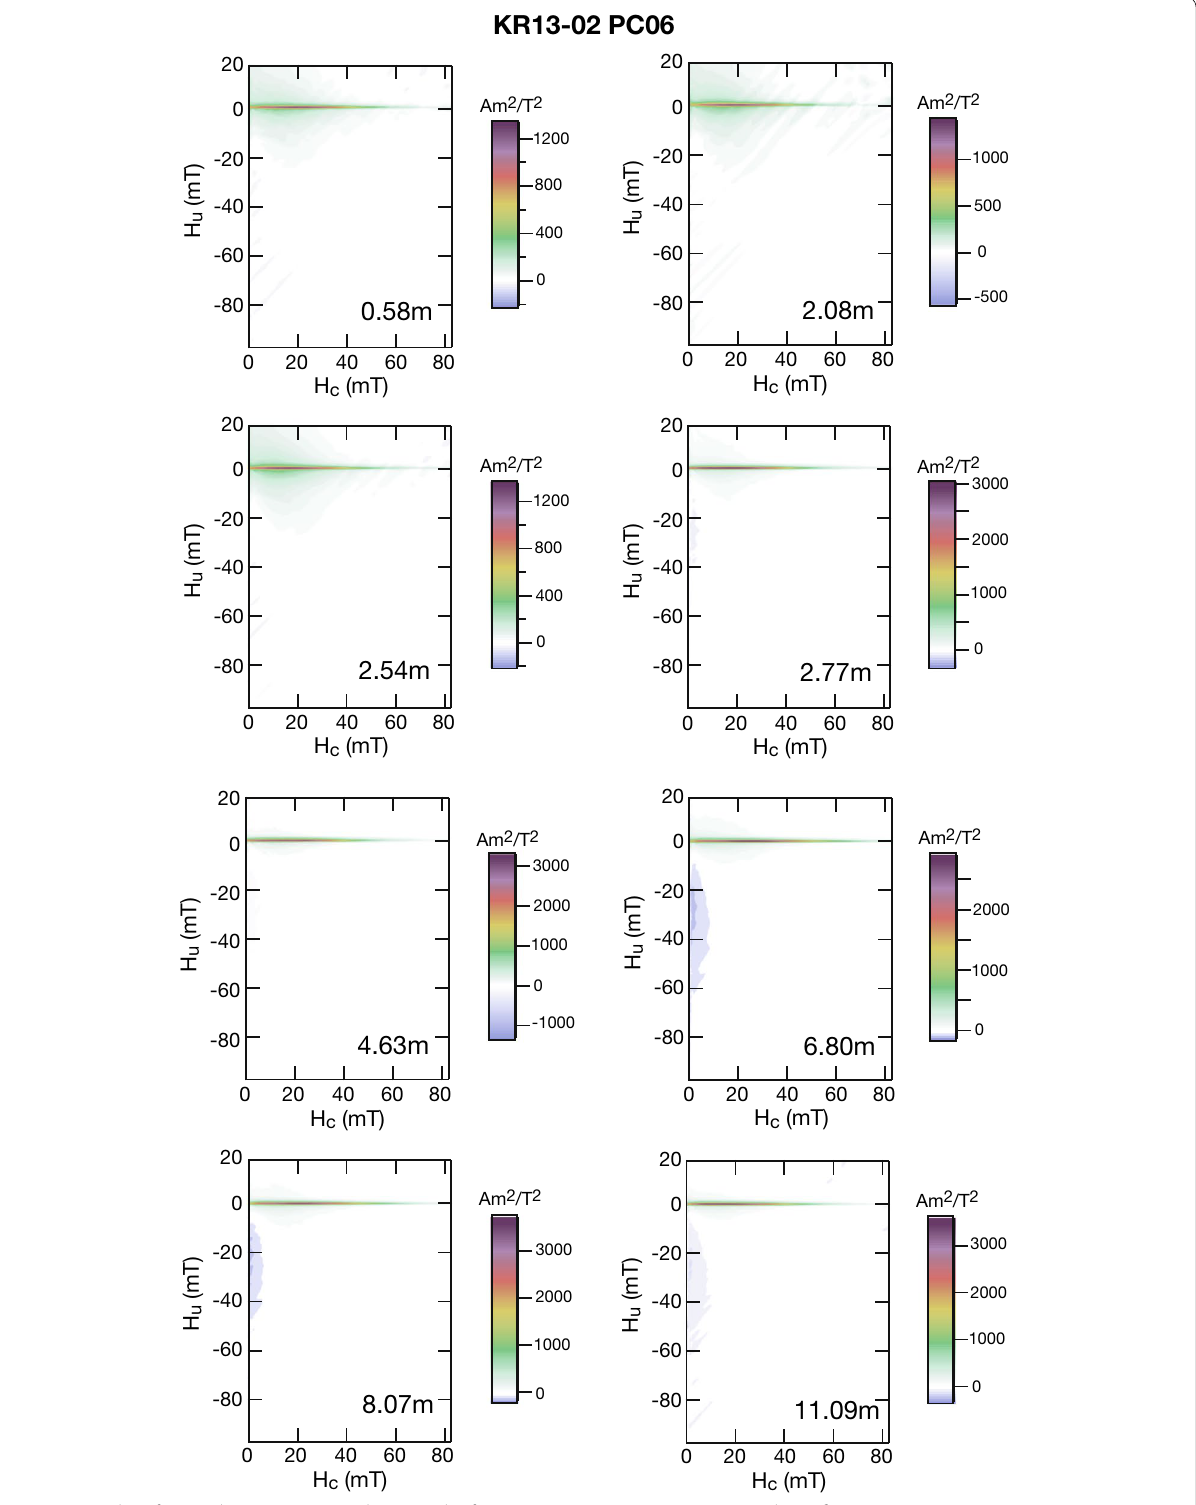
Fig. 3 Examples of FORC diagrams measured on samples from core KR13-02 PC06, western North Pacific